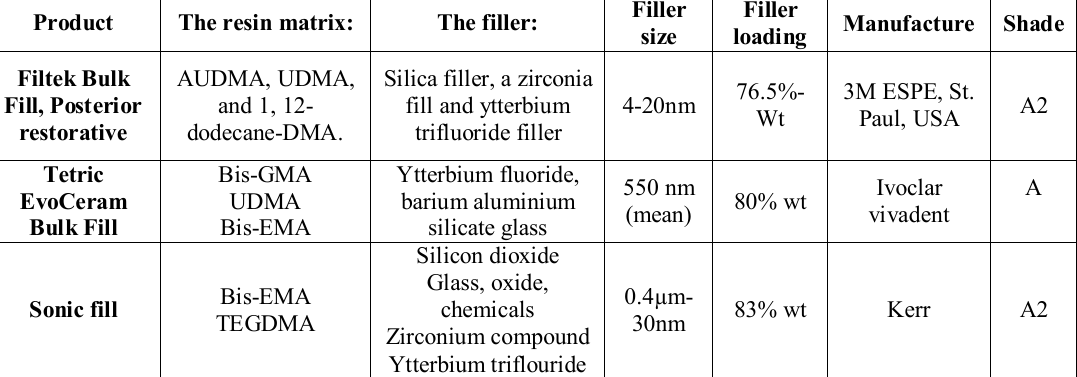
Table 1: Composition of the tested composite materials